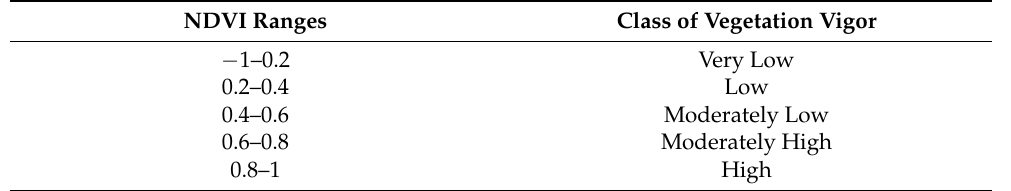
Table 3. Classification of NDVI